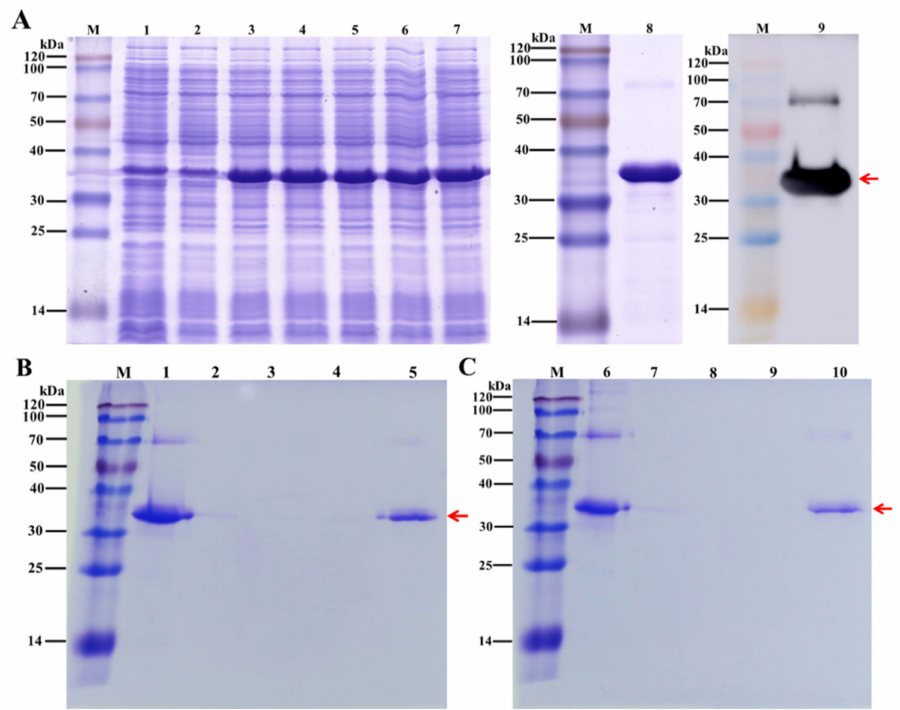
Figure 8. Analysis of the recombinant DcCP64 protein using SDS-PAGE and binding assays of recombinant protein DcCP64 to chitin and cellulose. The cellulose-binding assay was used as a control. ( A ) M: molecular weight markers. Lane 1: blank control without insert. Lane 2: negative control without induction. Lanes 3–7: induced expression under IPTG concentrations of 0.2, 0.4, 0.6, 0.8 and 1.0 mmol/L, respectively. Lane 8: purified recombinant DcCP64 protein. Lane 9: Western blotting analysis of recombinant His-tagged DcCP64 protein identified by anti-His antibodies. ( B ) and ( C ) Binding assays of recombinant protein DcCP64 to chitin and cellulose. Lane1 and Lane 6: flow-through. Lane (2–4) and Lane (7–9): the first and third washing fraction. Lane 5 and Lane 10: proteins eluted by 8 M urea. The red arrow indicates the recombinant DcCP64